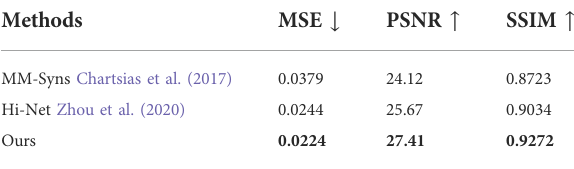
TABLE 3 Comparison results of the objective evaluation on multimodal synthesis (T1+T2 →